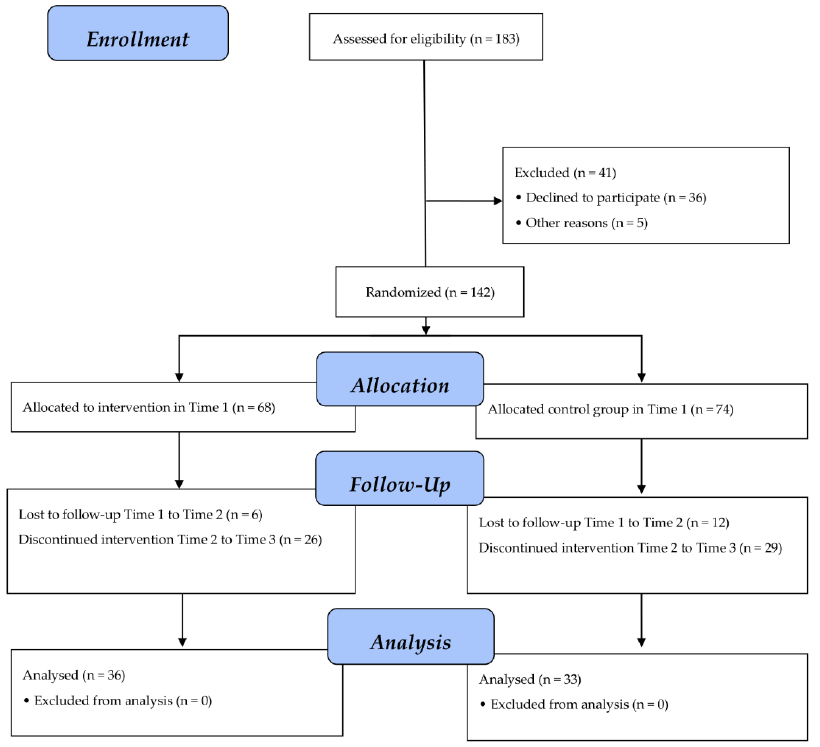
Figure 1. Consolidated Standards of Reporting Trials (CONSORT) flow diagram of participant recruitment.